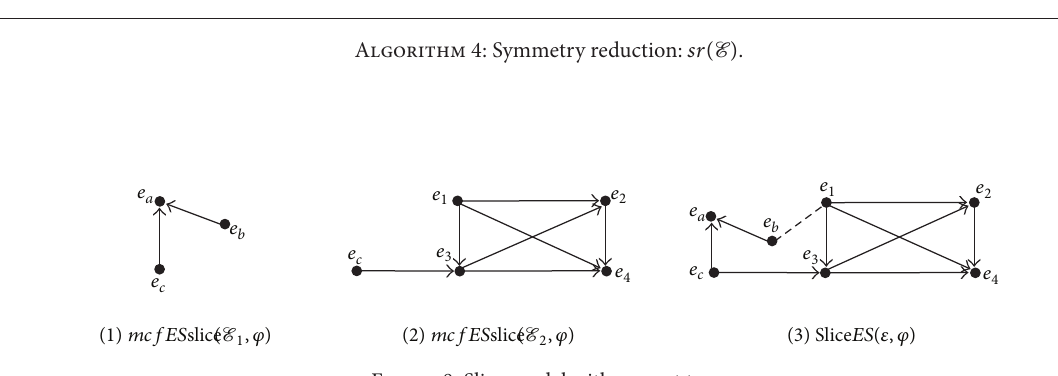
Figure 8: Slice model with respect to 𝜑